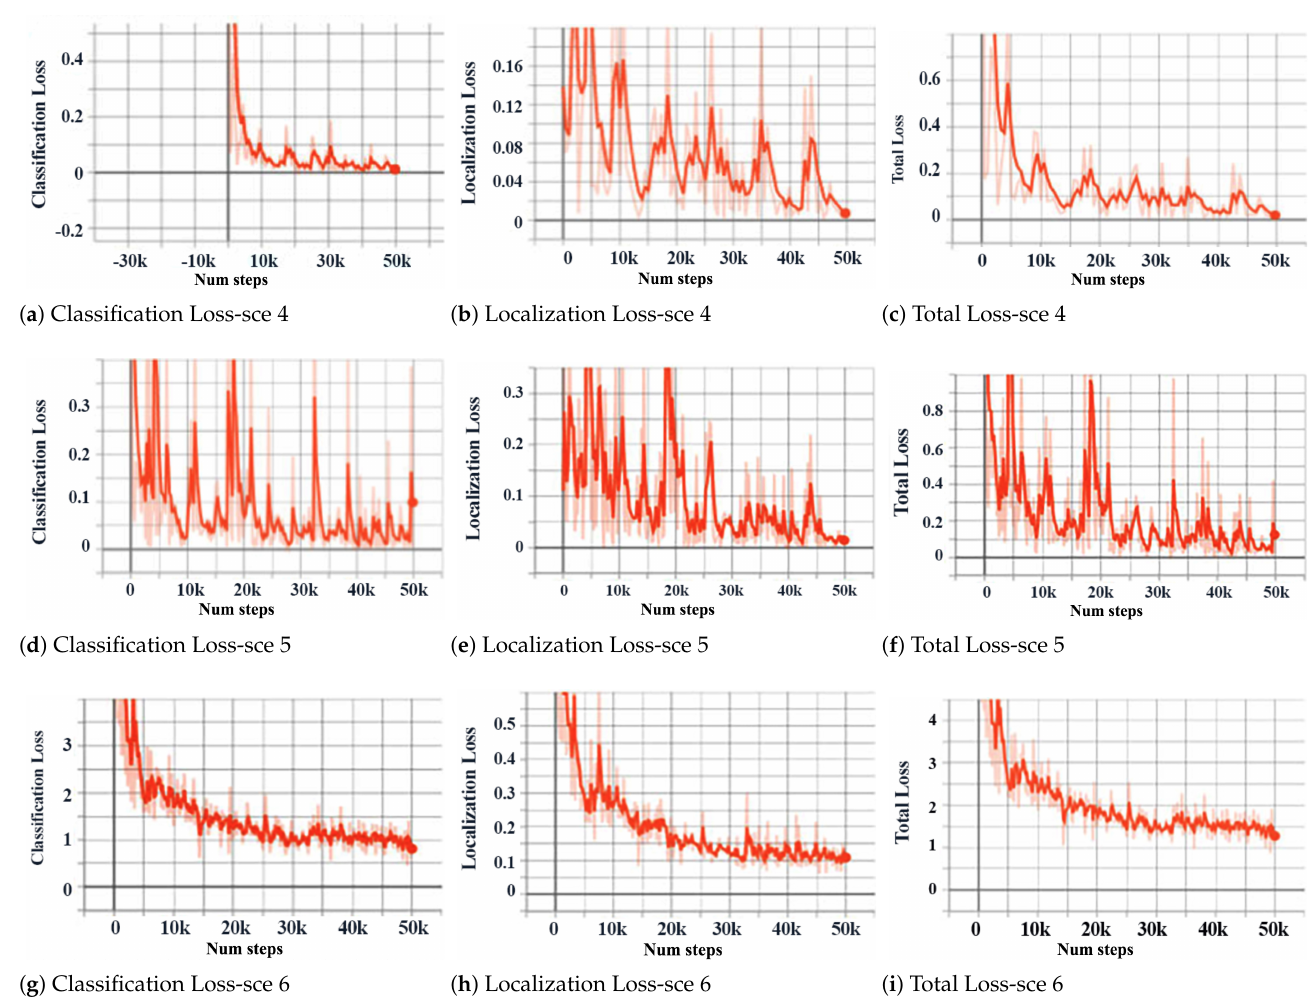
Figure 14. Histograms of the loss values for Scenarios 4, 5, and 6. Training